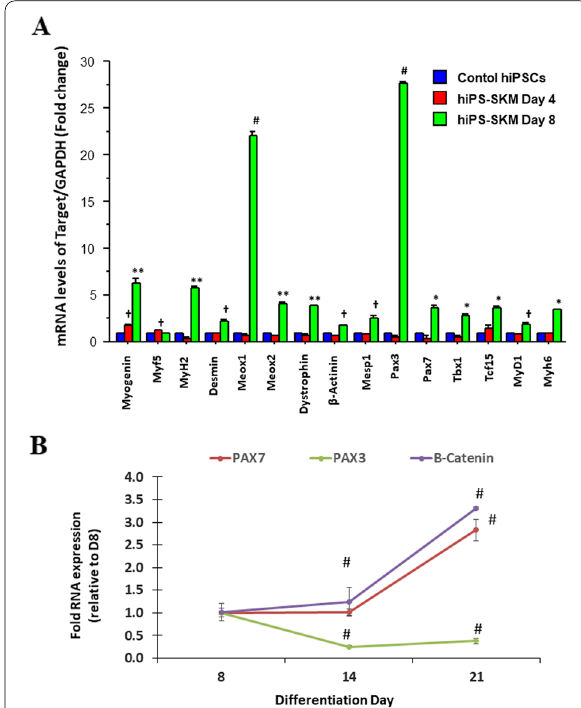
Fig. 4 Givinostat induce higher expression of skeletal myogenic genes: Skeletal muscle genes included Meox1, Meox2, Tcf15, Pax3, Pax7, MyoD1, dystrophin, myogenin, Myh2, Myh6, Tbx1, Mesp1, desmin and β-catenin. GIV increased upregulation of skeletal myogenic genes (Real Time PCR-analysis) in skeletal iPSCs (hiPSC- SKM) at first 4 days and further increased after 8 days versus control ( A ). Skeletal maturity genes were followed up at day 14 and Day 21 with normalized to day 8 ( B ). Values are mean SE; n 3; † ± = P- value < 0.05, * P- value 0.01, ** P- value 0.001, # P- value 0.0001 = = = are